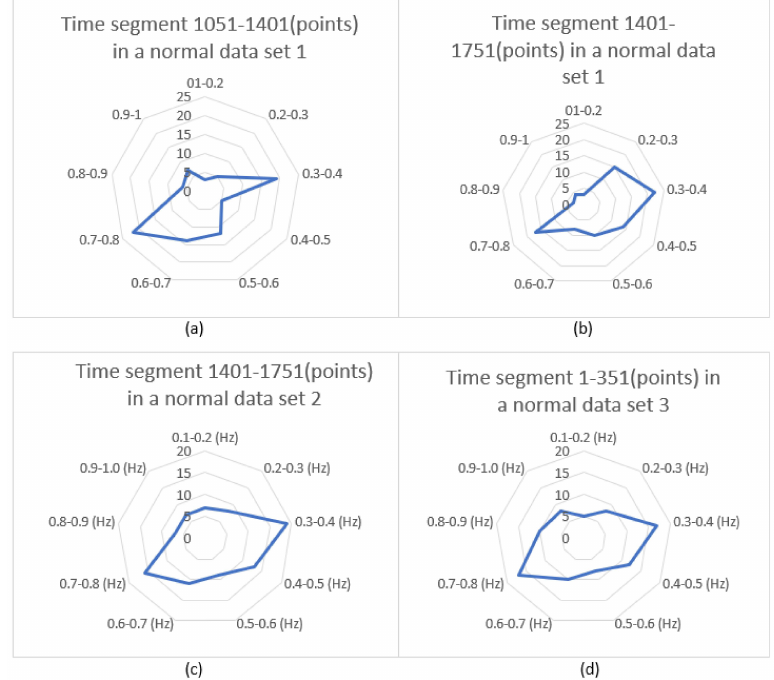
Figure 9. Number of pulses in different frequency ranges for “normal” data sets: ( a ) feature 1 in time segment 1051–1401 (points) of data set 1, ( b ) feature 2 in time segment 1401–1751 (points) of data set 1, ( c ) feature 3 in time segment 1401–1751 (points) of data set 2, ( d ) feature 4 in time segment 1–351 (points) of data set 3.